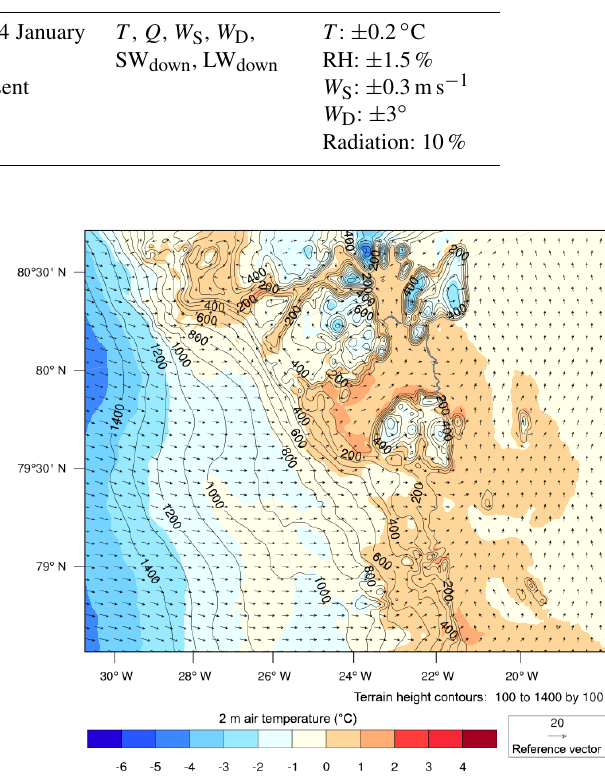
Figure 4. The 2m air temperature (colours), wind vectors (arrows), and terrain height contours (black lines) for 6 June 2015. The edge of 79 ◦ N Glacier is shown by the dark grey